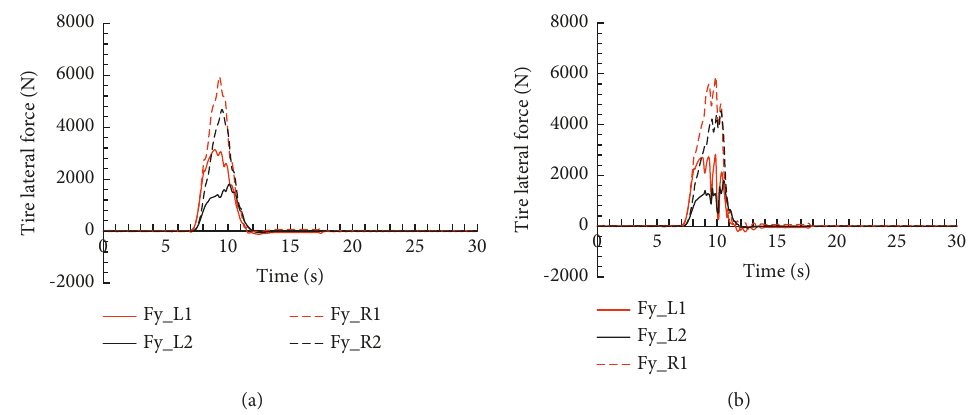
Figure 16: Tire lateral force curves with curve radius of 10 m: (a) on dry road; (b) on wet road.